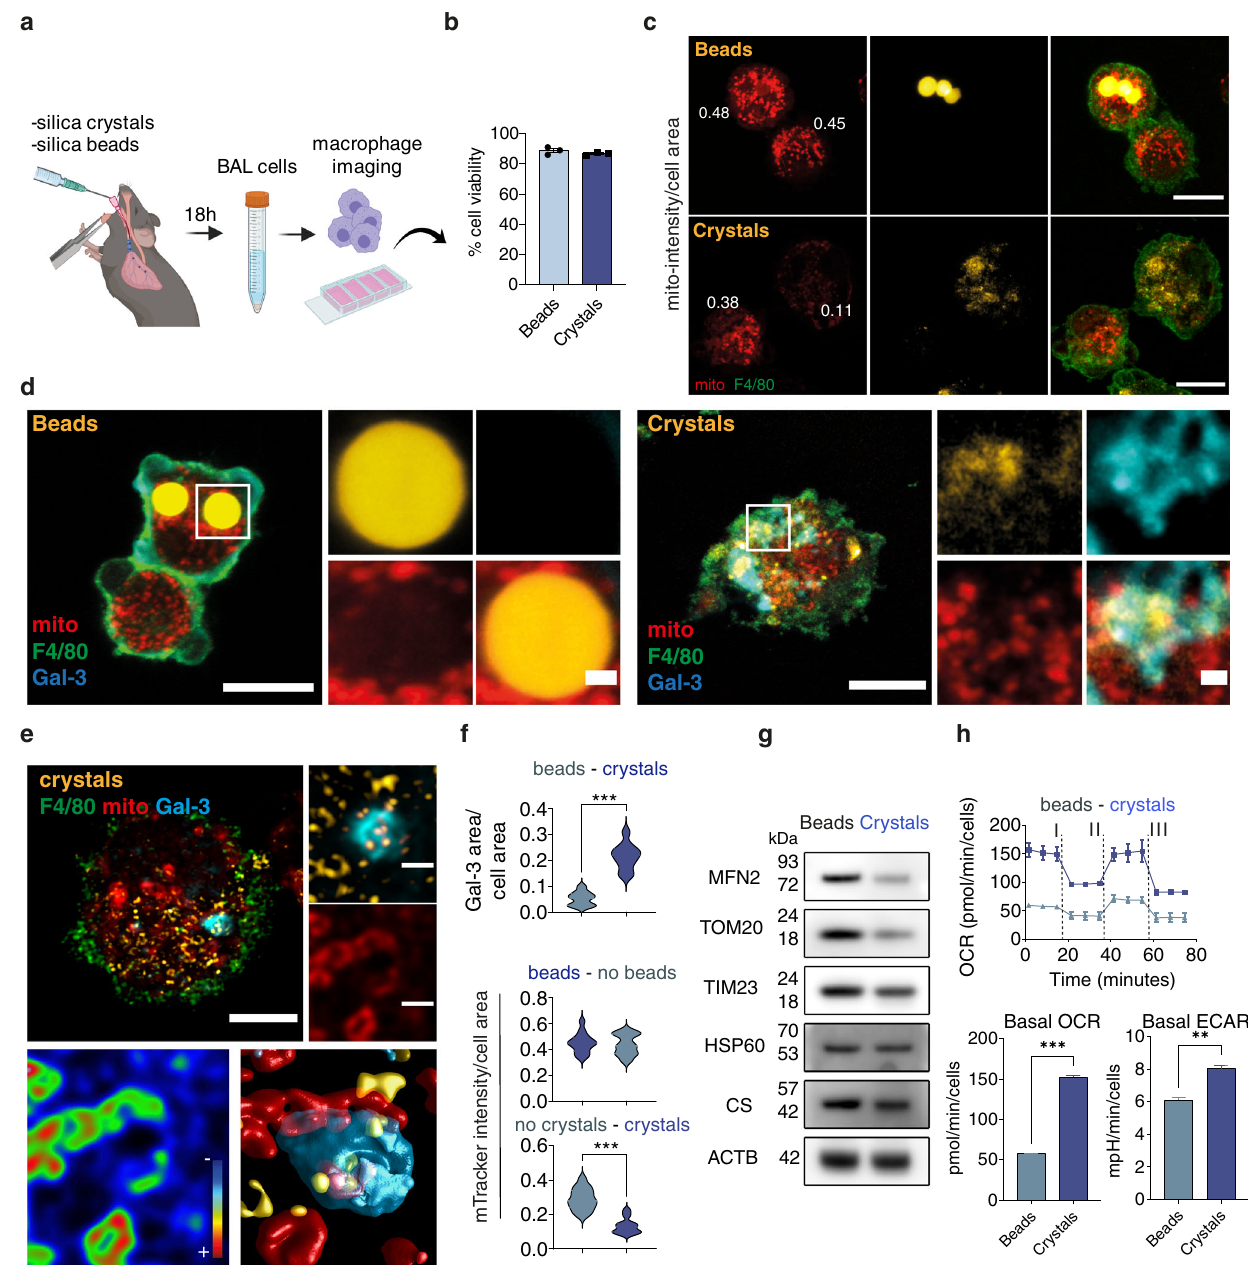
Fig. 6 | Lysosomal leakage affect mitochondrial activity and macrophage metabolism in vivo. a Mice were intratracheally intubated with silica crystals or beads and after 18h BAL fl uids obtained. b Bar graph shows cellular viability measured by trypan blue exclusion test ( n =3 independent experiments). c BAL cells were labelled with anti-F4/80 antibody and incubated with MitoTracker Deep Red for live-cell confocal imaging and mitochondrial fl uorescence intensity eva- luation. n =3independentexperiments. d BALcellswerelabelledwithMitoTracker Deep Red, fi xedand stainedforF4/80and Galectin-3(Gal-3). Crystals were imaged by re fl ection microscopy. n =3 independent experiments. e 3D Confocal imaging analysis of an F4/80+ macrophage with low membrane potential mitochondria in the proximity of a crystals-induced GAL-3-positive endolysosome. f Quantitative